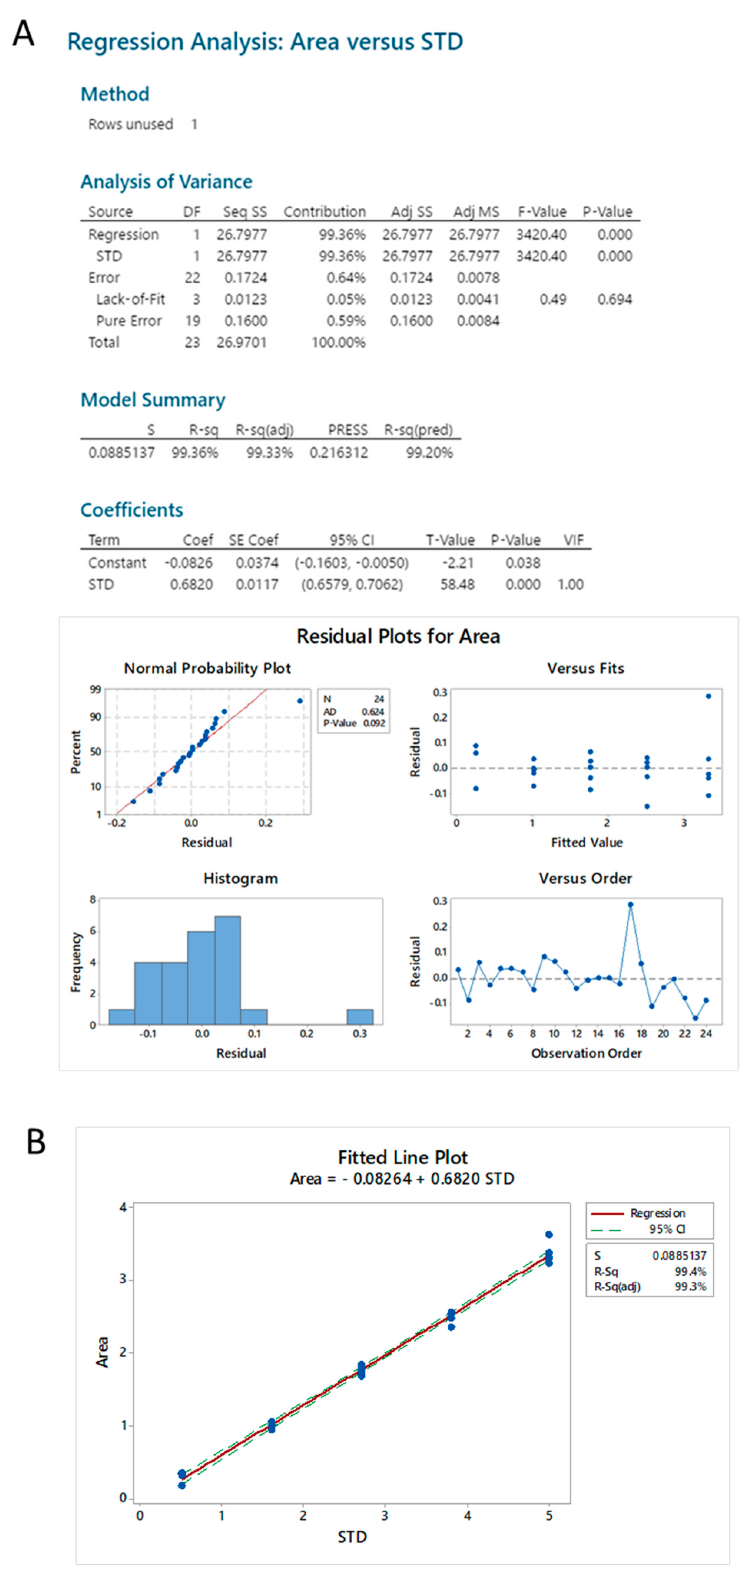
Figure A11. Standard Linearity determination for quantification of S. flexneri 6 OAg by acid hydrolysis followed by HPAEC-PAD: ( A ) ANOVA on 5 replicates for the OAg calibration curve; ( B ) calibration curve plot.